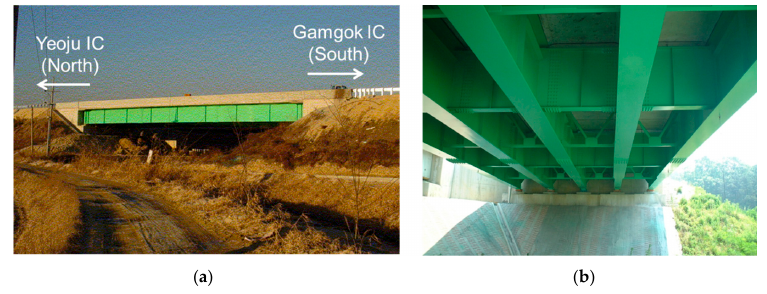
Figure 3. ( a ) Front view and ( b ) bottom view of Samseung Bridge, Korea.